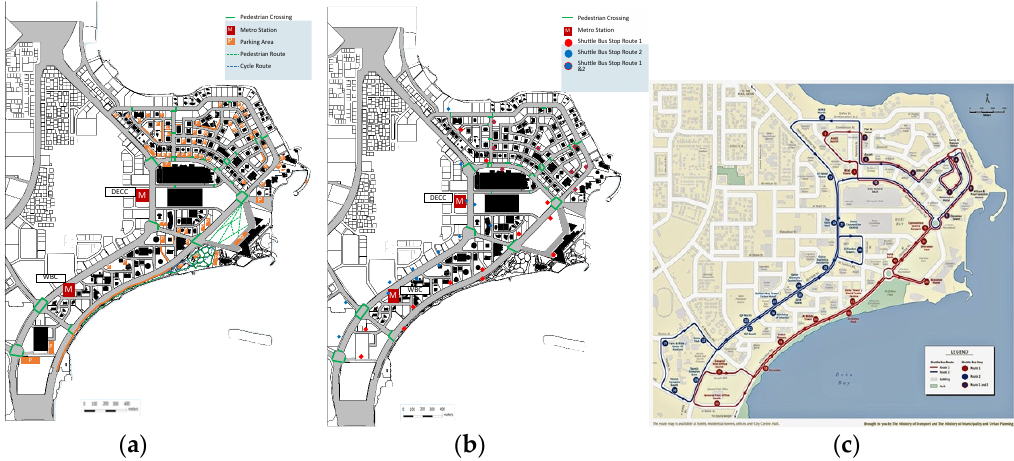
Figure 9. ( a ) Pedestrian, parking, and cycling map in West Bay; ( b ) transportation map in West Bay; ( c ) bus shuttle routes map in West Bay (source: the Ministry of Transportation and Ministry of Municipality and Environment in Qatar).